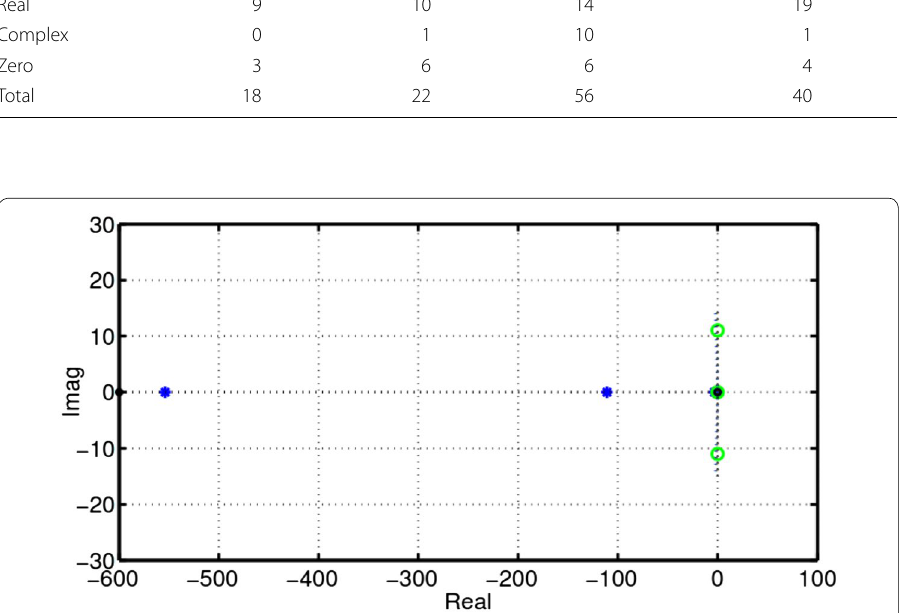
Fig. 5 Pole zero location of eigenvalues for the static